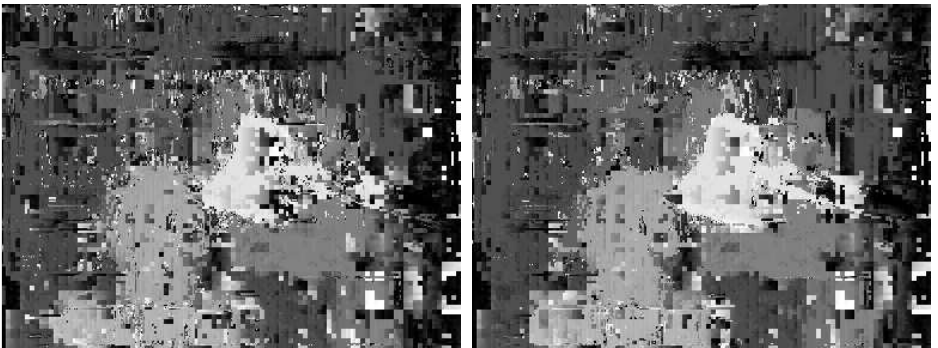
the coarsest level (level), and using always the scale images (right).